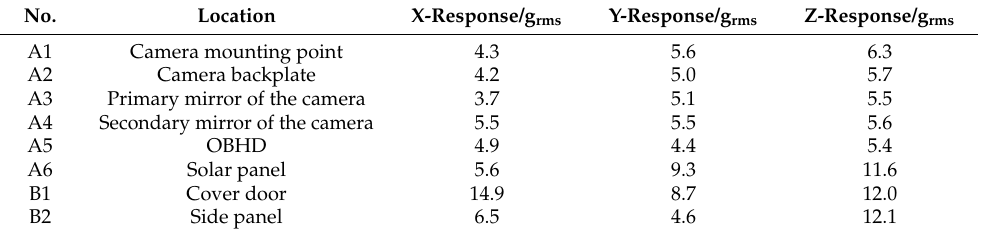
Table 7. Results of random vibration analysis.